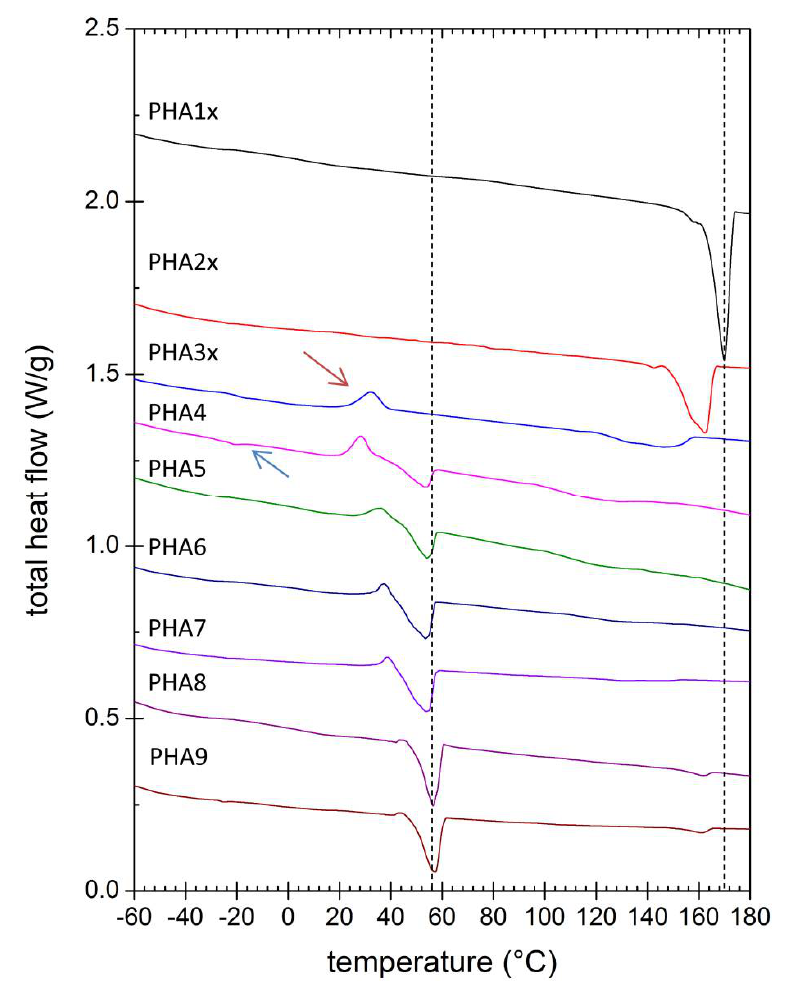
Figure 3. Differential scanning calorimetry (DSC) thermograms of PHA copolymer films Figure 3. Di ff erential scanning calorimetry (DSC) thermograms of PHA copolymer films (thermograms (thermograms show the second heating scan). show the second heating